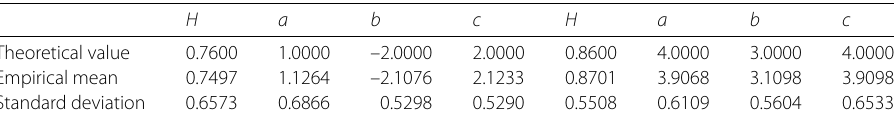
Table 1 The means and standard deviations of the estimators with N = 600 H a